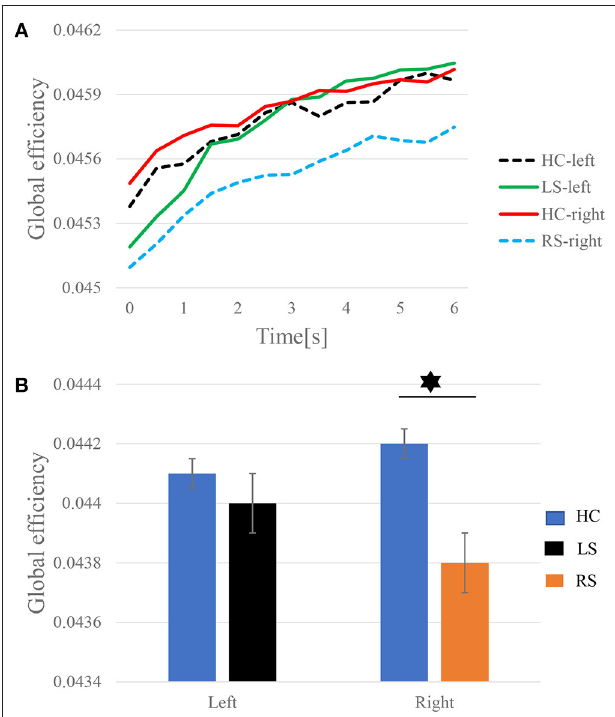
FIGURE 5 | The time-varying GE of left-hand and right-hand KMI recognition. (A) Dynamics of the GE. (B) Statistics of the average GE. The asterisk represents significant differences in GE between the two groups ( p < 0.05).